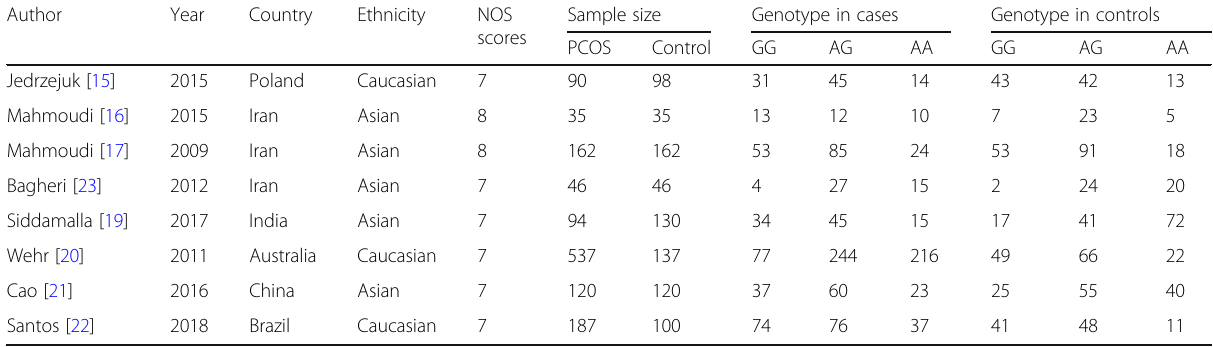
Table 2 Characteristics of studies on VDR BsmI rs1544410 (A > G) variant and polycystic ovarian syndrome (PCOS)